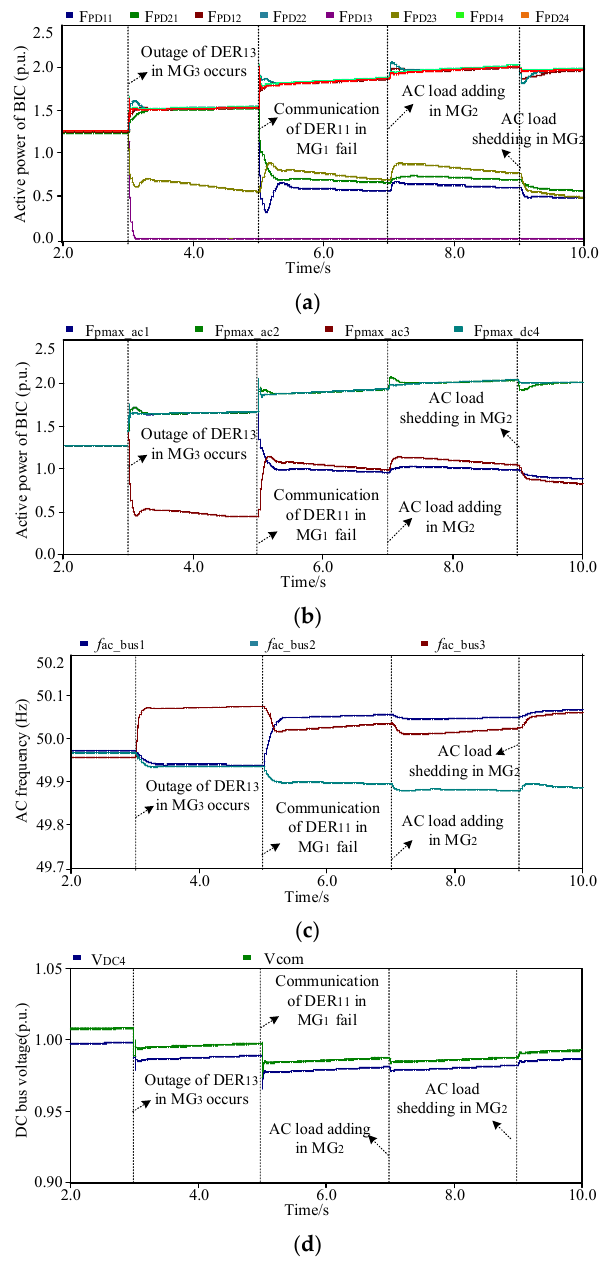
Figure 18. Performance of conventional distributed control under outages and communication failures of the pinned DERs: ( a ) Output power of AC/DC DERs, ( b ) Output power of BICs, ( c ) Frequencies of AC MGs, ( d ) Voltages of common bus and DC MG.